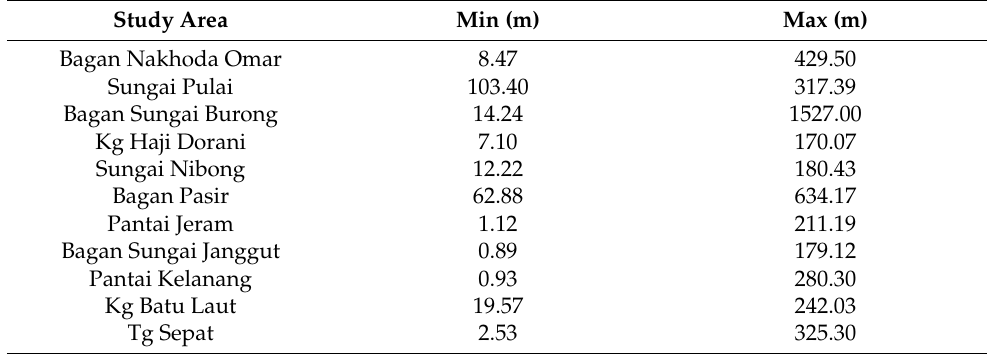
Table 3. Minimum and maximum distance of shoreline from baseline for the transects. Study Area